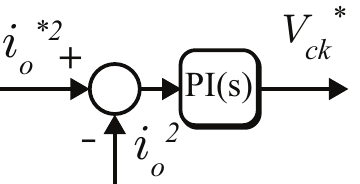
Figure 11. Control scheme for MMC